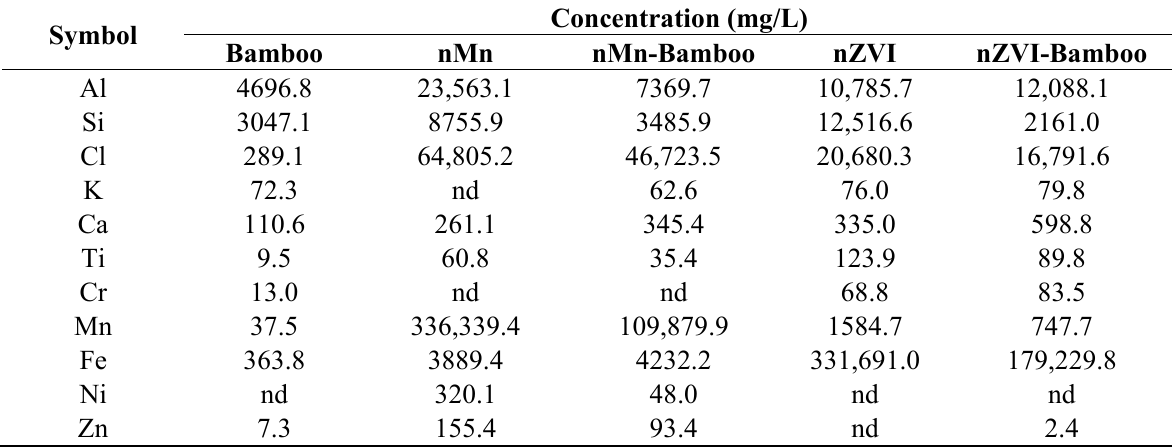
Table 2. Concentration of elements in bamboo, nMn, nMn-bamboo, nZVI, and nZVI-bamboo composite by PIXE